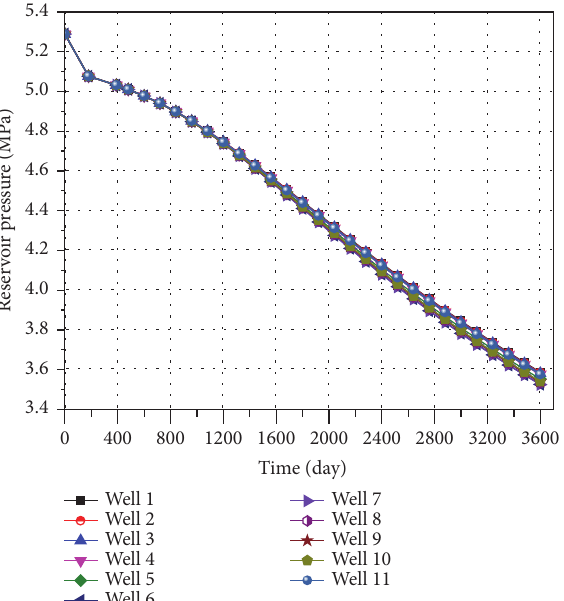
Figure 13: Reservoir